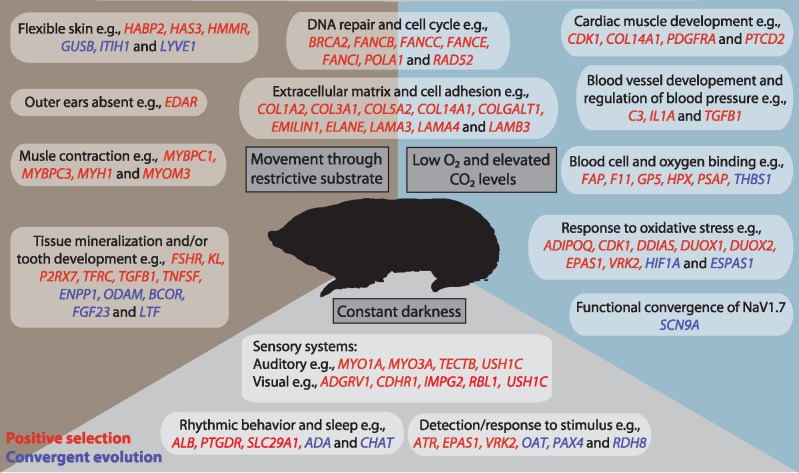
Illustration of three of the dominant environmental pressures acting on subterranean mammals and the possible molecular adaptations evolved in response to these pressures. Listed genes are colored as follows: red—under positive selection in at least one subterranean lineage; blue—total PP of convergence ≥ 1.00 between at least one pair of subterranean taxa.